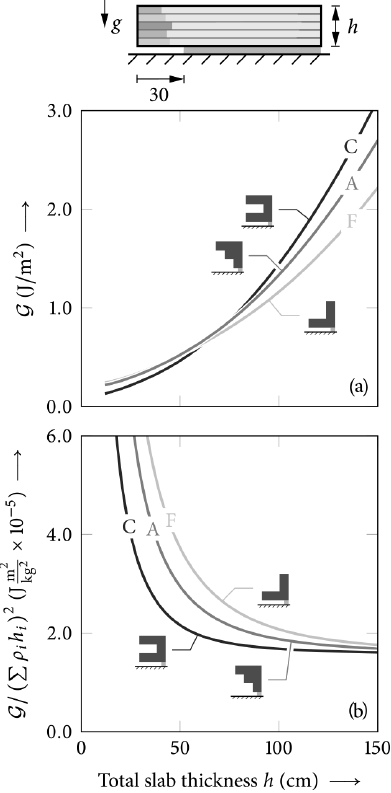
Figure 16. Bridging effect on the energy release rate in flat PST experiments. (a) Total differential energy release rate G for profiles C, D, and E. (b) Energy release rate G normalized with re- spect to the square of the total slab weight (cid:80) ρ i h i